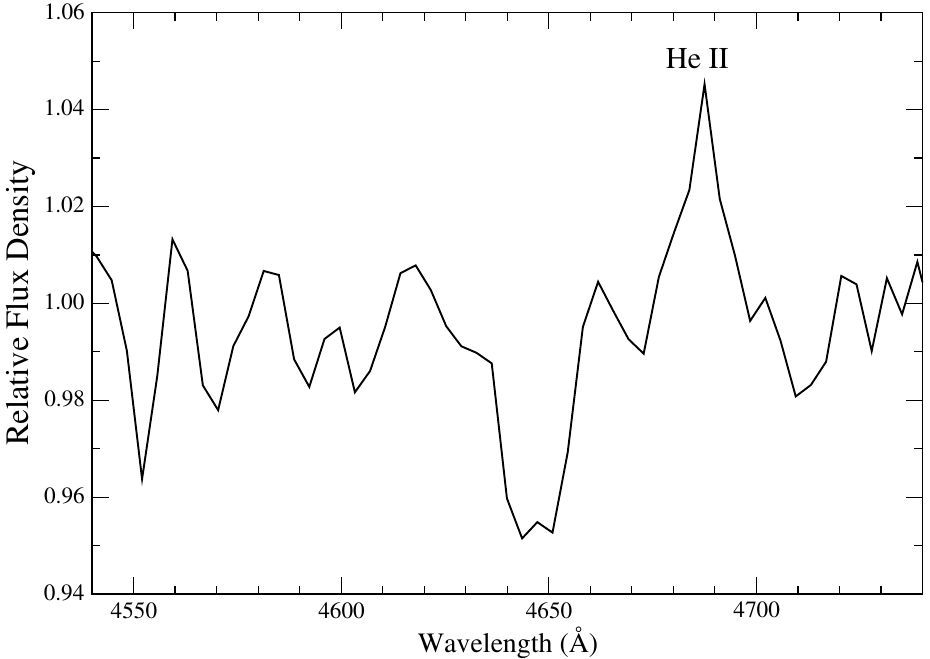
Figure 3. Low-resolution optical spectrum of HD 3191 as observed from the OUJA on 16 December 2019. The He II emission line at 4686 Å is prominently detected above the stellar